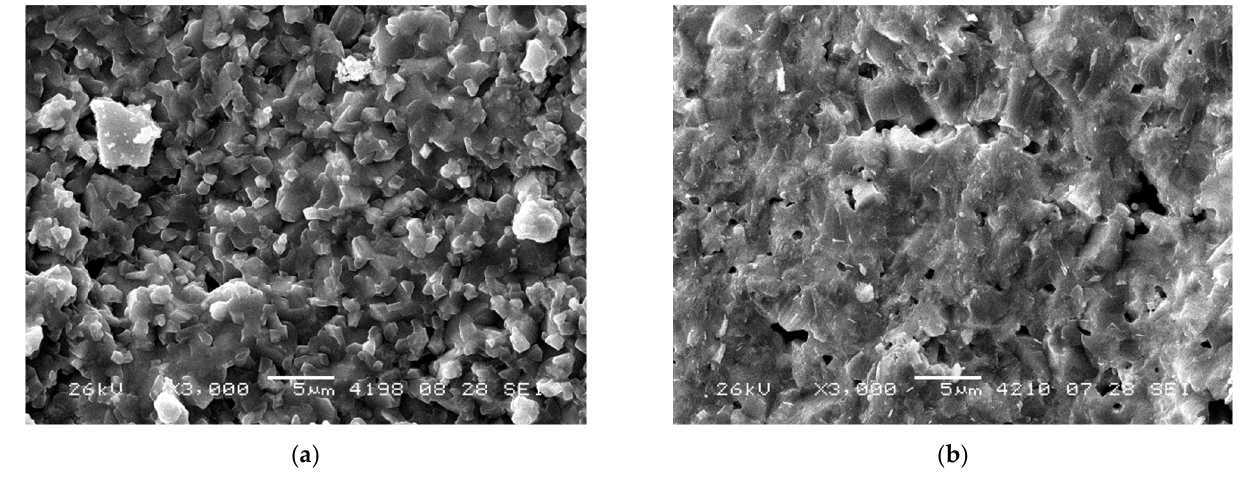
Figure 3. SEM micrographs of the NWMO sample obtained by mechanical activation and RTS at 1100 °C acquired from the base ( a ) and the side ( b ) of the pellet.